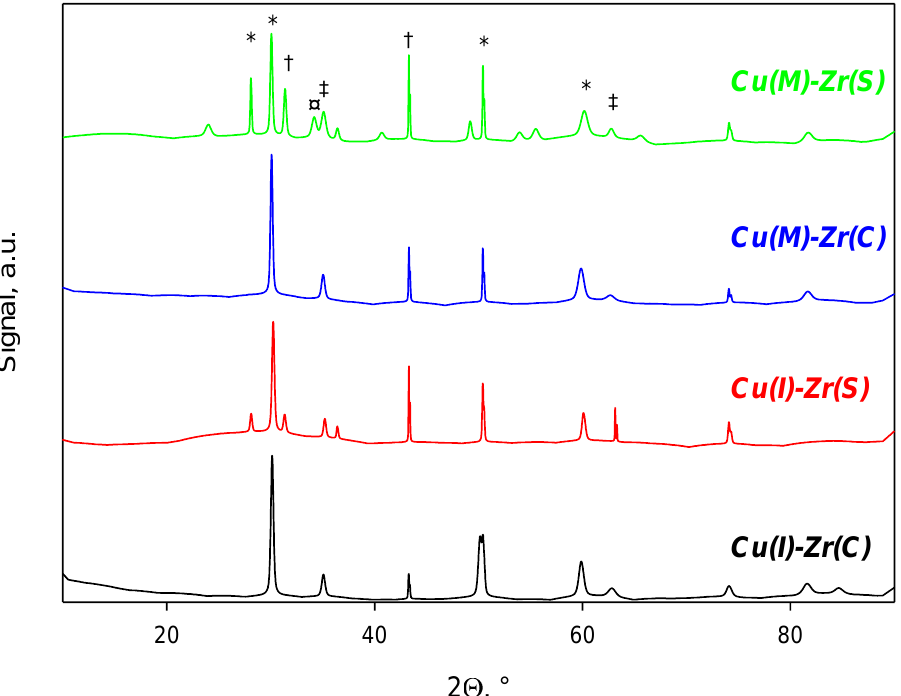
Figure 1. XRD patterns of used samples. *: ZrO 2 ; †: Cu; ‡: Cu 2 O; ¤: CuO.